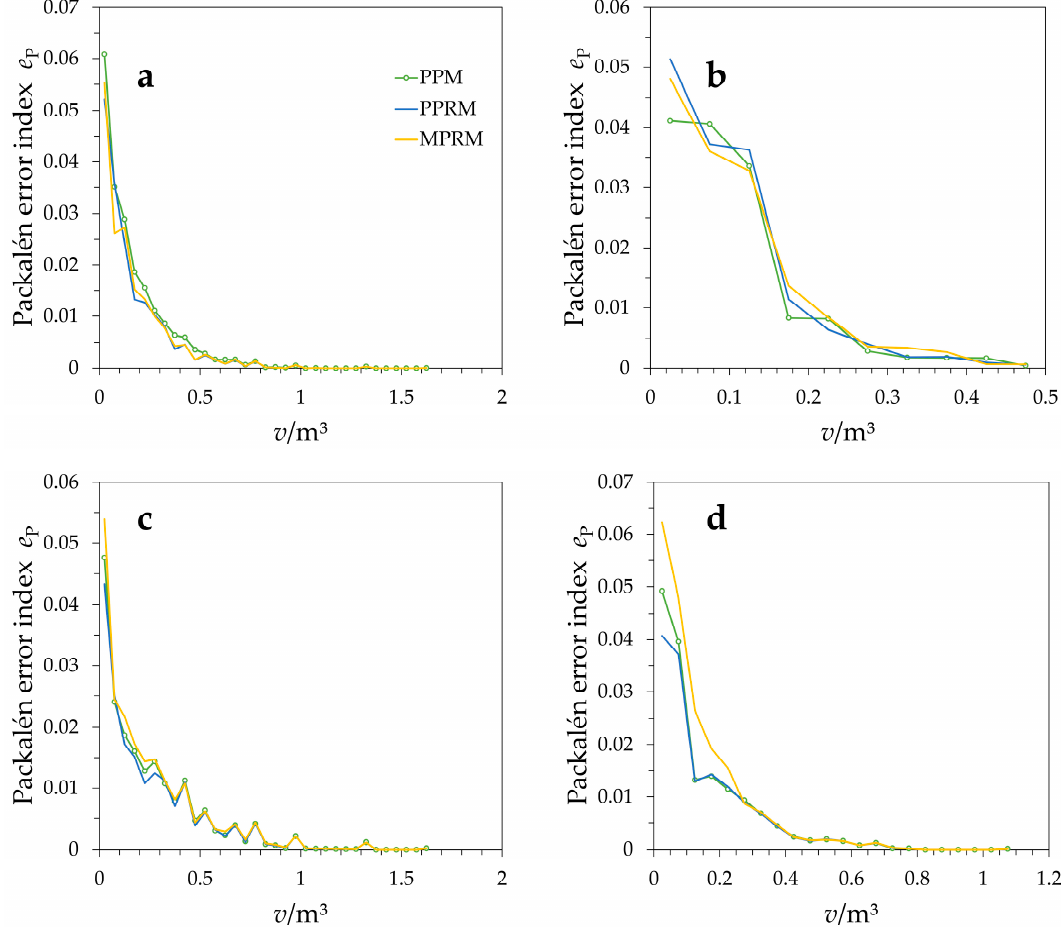
Figure 8. Mean value of the Packalén error index e p by each tree volume class of predicted tree volume distributions based on the PPM, PPRM, and MPRM. ( a ): all plots; ( b ): coniferous forests; ( c ): broadleaved forests; ( d ): mixed forests. PPM: parameter prediction method; PPRM: percentile-based parameter recovery method; MPRM: moment-based parameter recovery method.